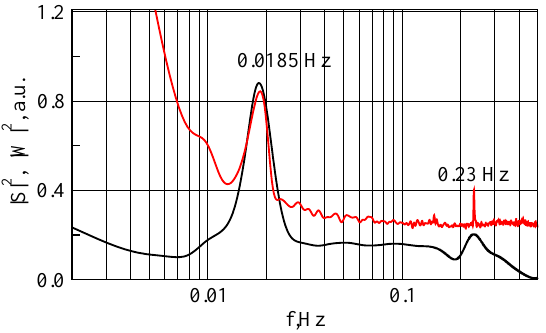
Fig. 5. Experimental data on kidney blood °ow. Fourier (red) and wavelet (black) power spectra both obtained by averaging over space and time. Peaks at f ¼ 0 : 0185 Hz and f ¼ 0 : 23 Hz corresponds to the TGF and to the myogenic response. N A ¼ 431680.